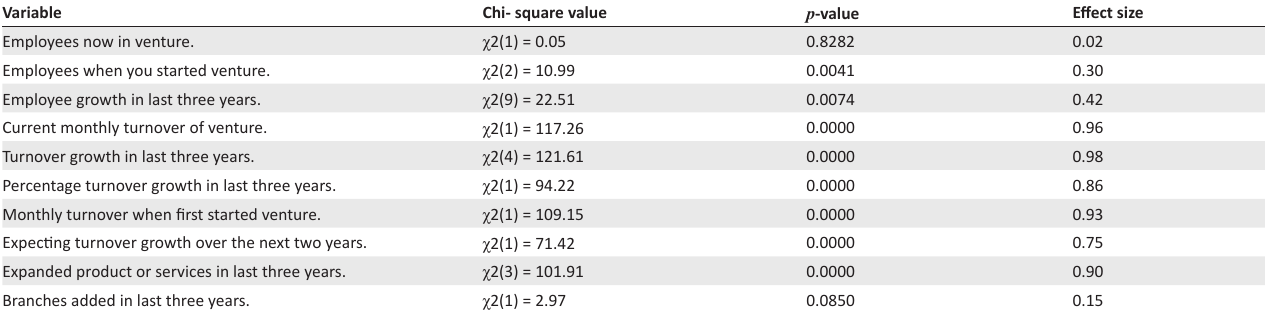
TABLE 5: Differences in clusters on performance